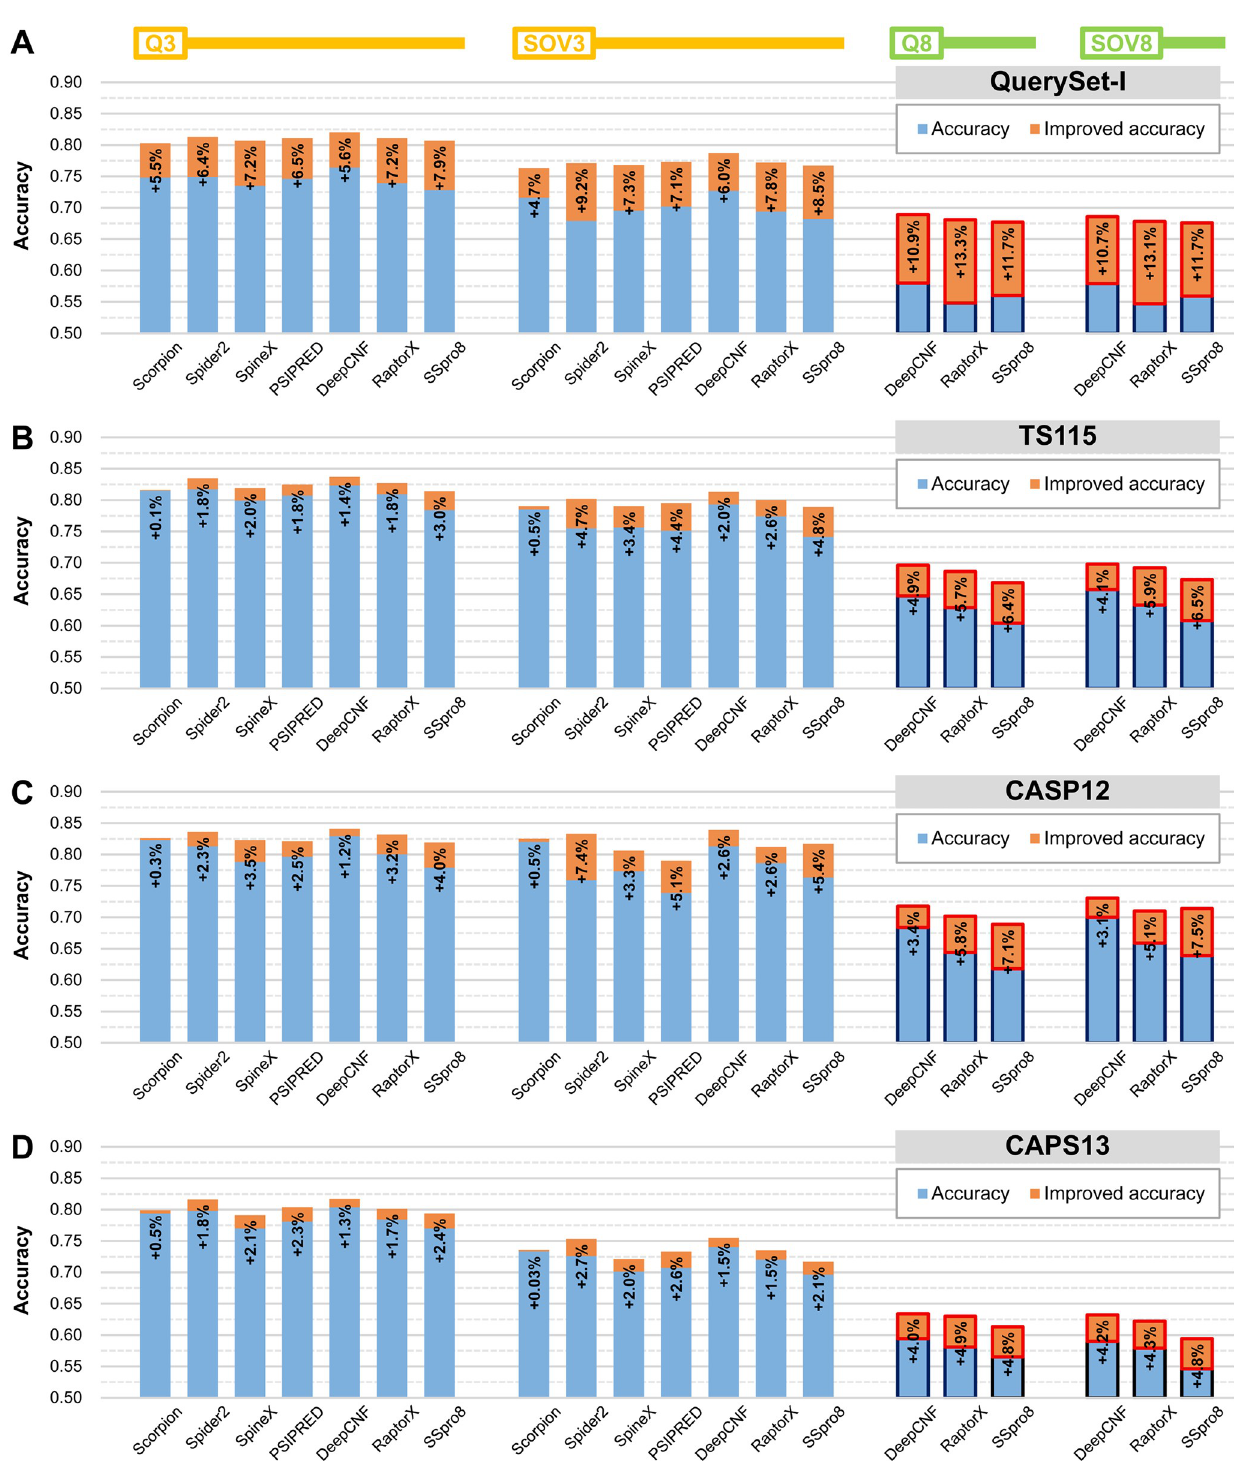
Fig 2. Performance of preliminary incorporation of SSE-PSSM into state-of-the-art SSP methods using PSI-BLAST to generate PSSM. (A) QuerySet-I against TargetSet-nr25, the developmental PSSM target dataset of this study. (B) TS115 against UniRef90-2015, the standard PSSM target dataset used in most SSP works. (C) CASP12 against UniRef90-2015. (D) CASP13 against UniRef90-2015. The SSE-PSSM was preliminarily incorporated with different SSP methods using a second-level machine learning feature set integration strategy. After the feature integration, the accuracy of most methods was significantly improved, especially in Q8 and SOV8. The fundamental prediction feature set of all the tested SSP methods are the amino acid PSSM generated by PSI-BLAST.